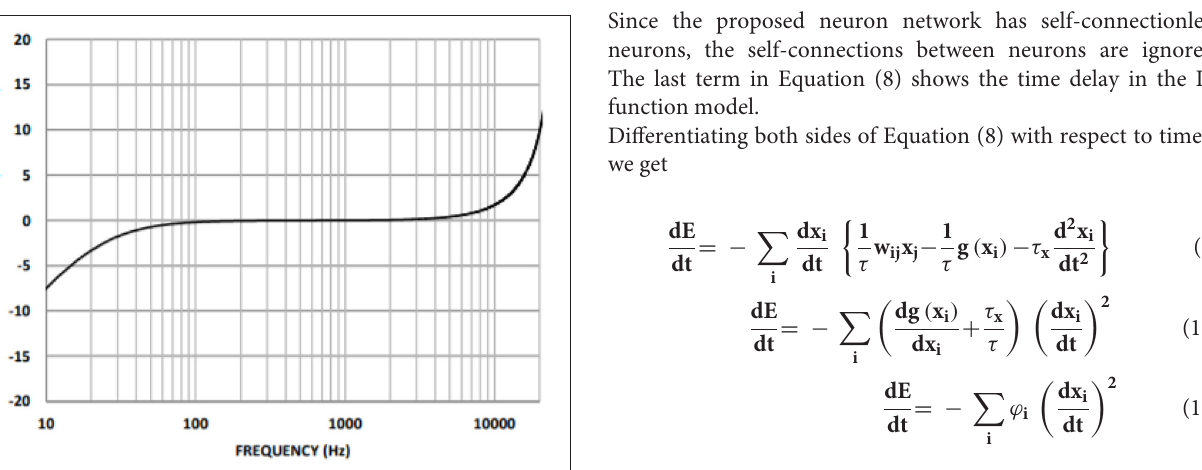
FIGURE 2 | Micro-electromechanical system (MEMS) microphone frequency response.